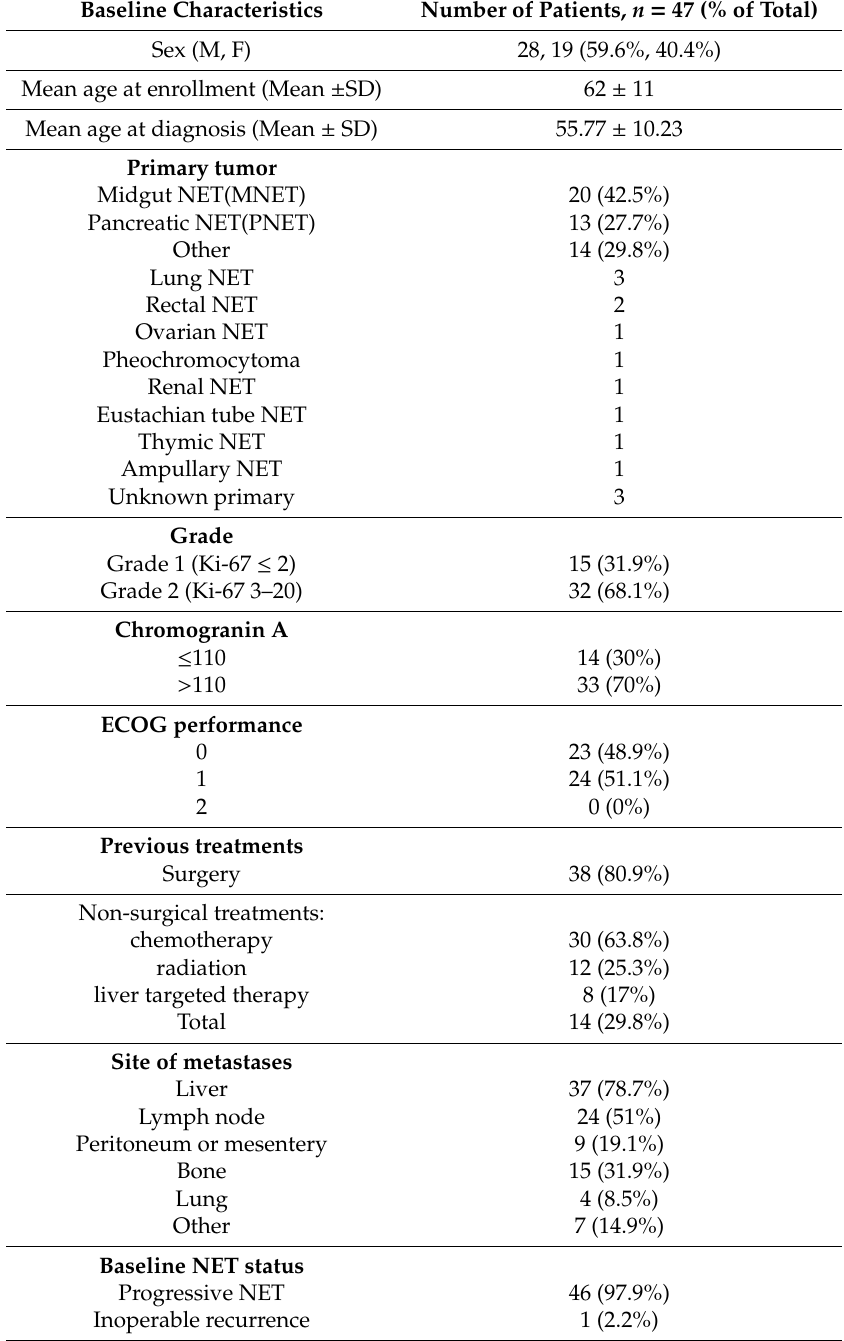
NET: neuroendocrine tumor. SD: Standard